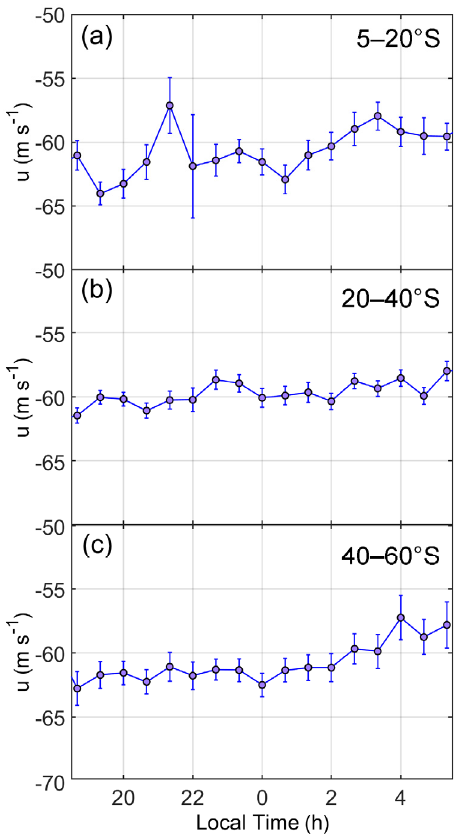
Figure 6. Local time profiles of the zonal wind speed constrained in latitude bins of 5–20° S ( a ), 20– 40° S ( b ) and 40–60° S ( c ). Error bars show standard error for a 99% confidence interval.